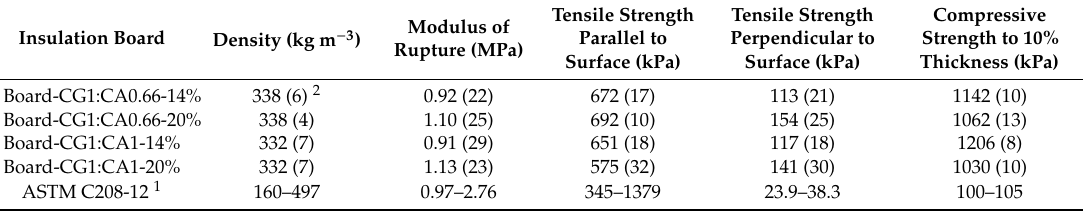
Table 7. Physical and mechanical properties of wood fiber insulation boards.